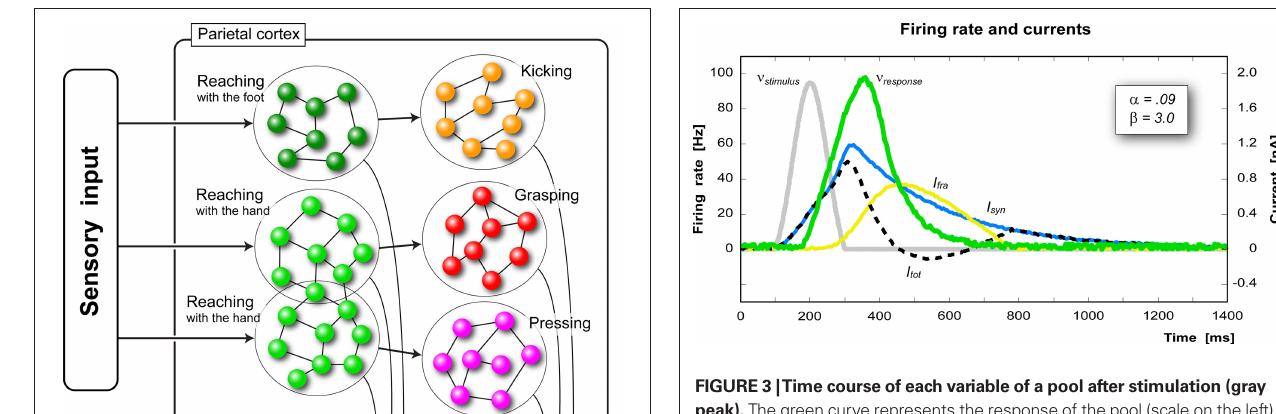
Figure 3 | Time course of each variable of a pool after stimulation (gray peak). The green curve represents the response of the pool (scale on the left), the blue curve is the synaptic current, the yellow curve is the firing rate adaptation current, and the dashed line is the resultant total current (current scale on the right).